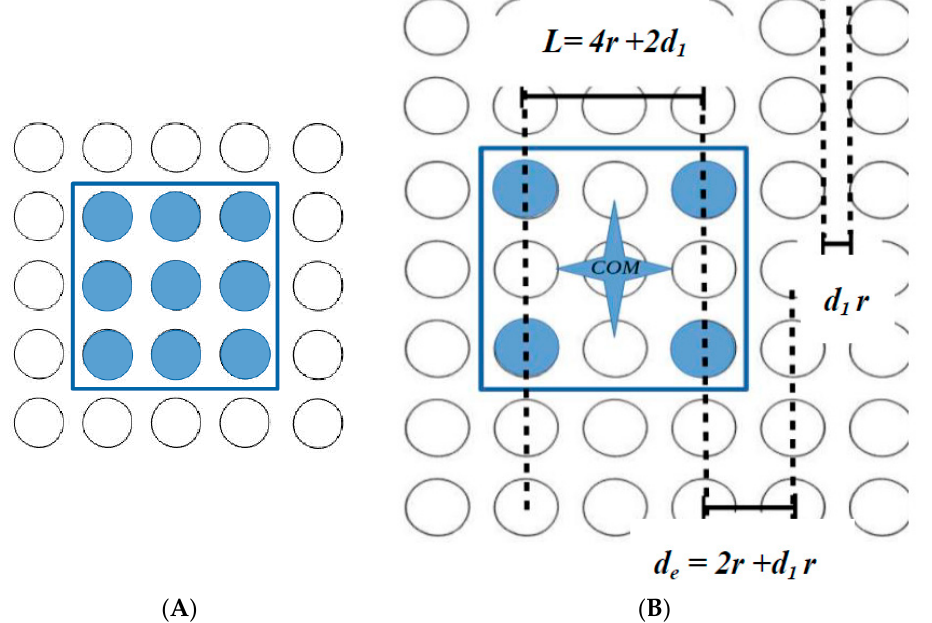
Figure 3. ( A ) The layout of a rectangular micropart embedded with 3 × 3 circular conductive electrodes [22]. ( B ) The layout of a rectangular micropart embedded with 2 × 2 circular conductive electrodes.